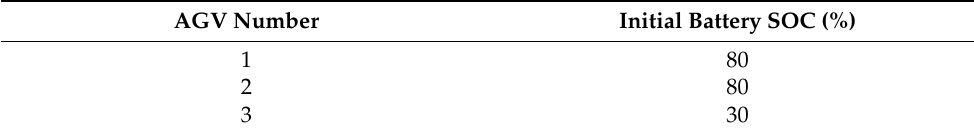
Figure 11. Coordinates of each position in the workshop. Table 1. Initial battery SOC of AGV Table 1. Initial battery SOC of AGV system.